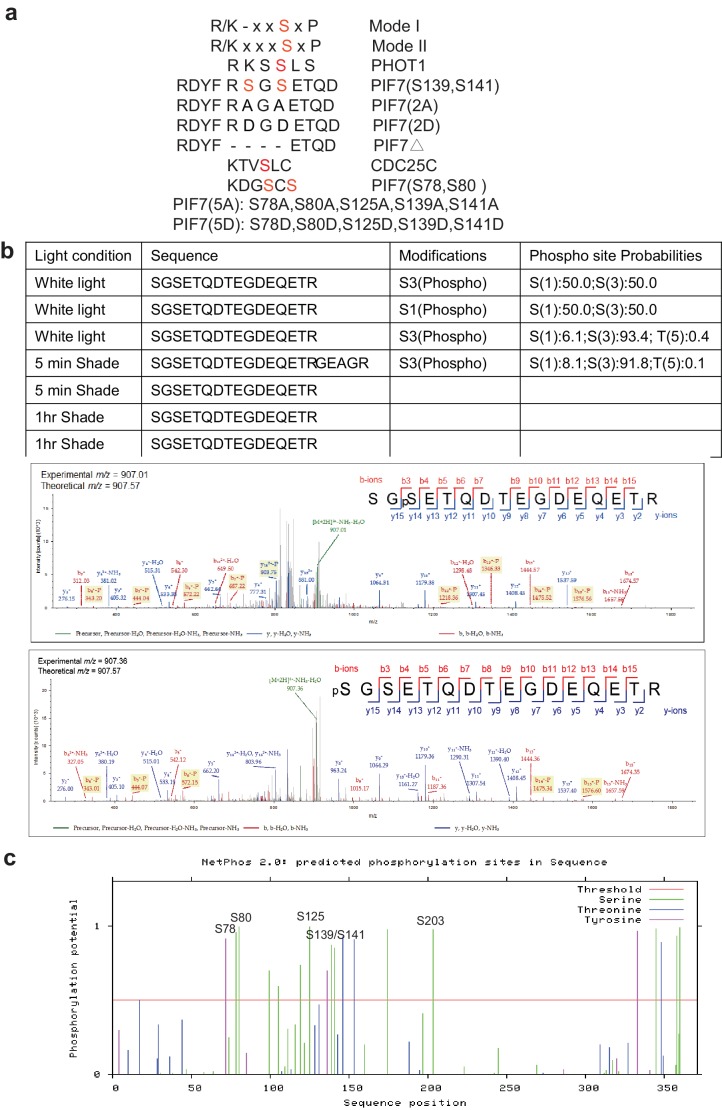
Potential phosphorylation sites on PIF7.(a) Two known 14-3-3 binding sequences (mode I and mode II) and putative 14-3-3 binding sequences in PIF7, PHOT1 and CDC25C are listed. The consensus phosphorylation sites are labeled in red. S139 and S141 of PIF7 were identified by LC-MS/MS from PIF7 immunoprecipitated proteins isolated from transgenic plants overexpressing PIF7-Flash. S78 and S80 of PIF7 were predicted as phosphorylation sites by NetPhos 2.0. (b) Identification of PIF7 phosphorylation sites from an LC-MS/MS experiment using immunoprecipitated PIF7 proteins isolated from 35S::PIF7-Flash transgenic plants. The light treatment of the samples, the sequence of the mapped peptide, the modifications of the peptide, and the probability for each site are presented in the table. The peptide with phosphorylated modifications was identified by mass spectrometry. (c) Phosphorylation sites of PIF7 as predicted by NetPhos 2.0 (http://www.cbs.dtu.dk/services/NetPhos/).